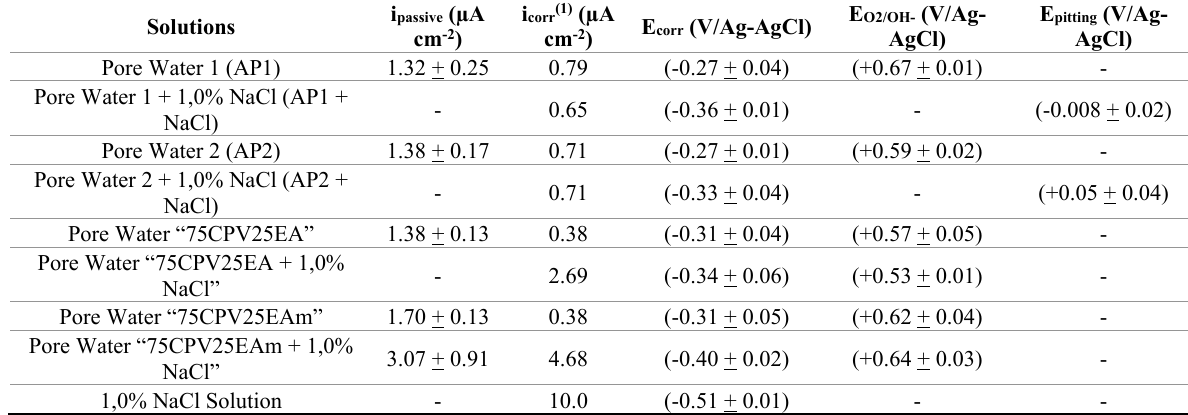
Table 5. Electrochemical parameters determined from the triplicate of the CA-50 steel polarization curves in the different pore water simulant